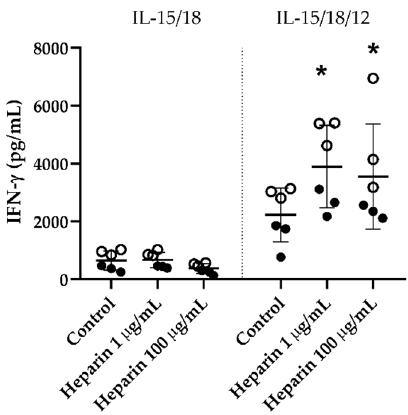
Figure 4. Heparin further increases IL-12-mediated IFN- γ production by human NK cells. NK cells isolated from umbilical cord blood were cultured in the presence of rIL-15 (50 ng / mL) and rIL-18 (50 ng / mL), with or without heparin (1 or 100 µ g / mL) or rIL-12 (10 pg / mL) for 24 h. The supernatant was collected and IFN- γ quantified by ELISA. Each point represents technical replicates from two independent experiments (represented by full and empty symbols; presented as mean ± SEM). An unpaired t -test was used to compare di ff erences between groups, where * p < 0.05 was used to compare to control.